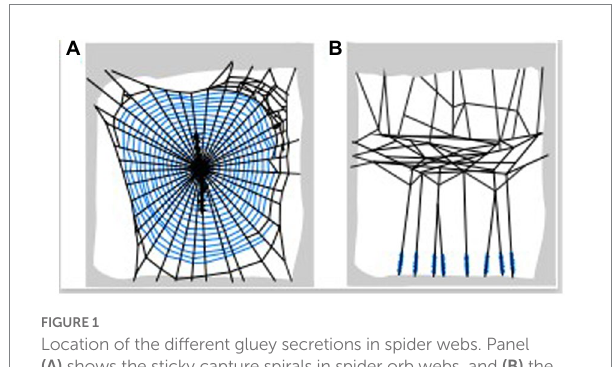
FIGURE 1 Location of the different gluey secretions in spider webs. Panel (A) shows the sticky capture spirals in spider orb webs, and (B) the gumfoot capture threads of